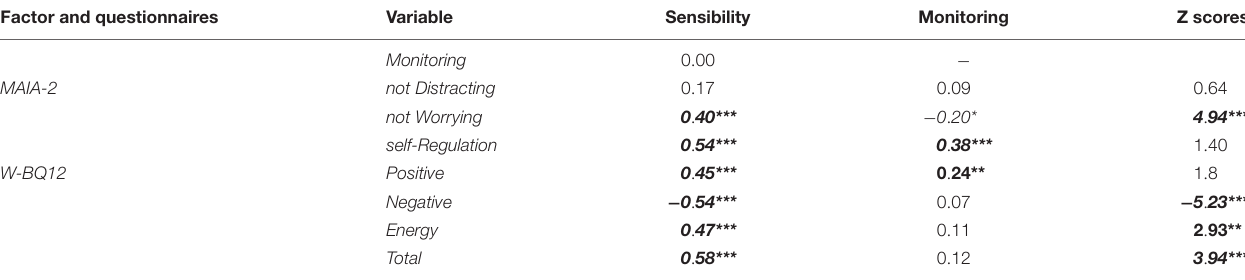
TABLE 4 | Pearson’s correlation between factor scores and well-being and adaptability measures. Factor and